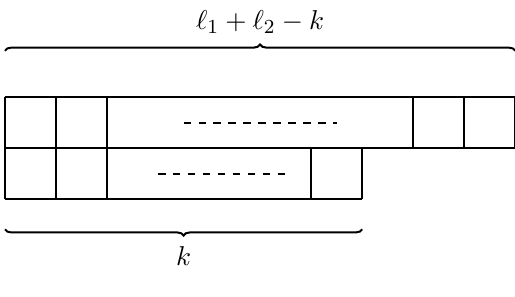
Figure 2 . Young diagram with two